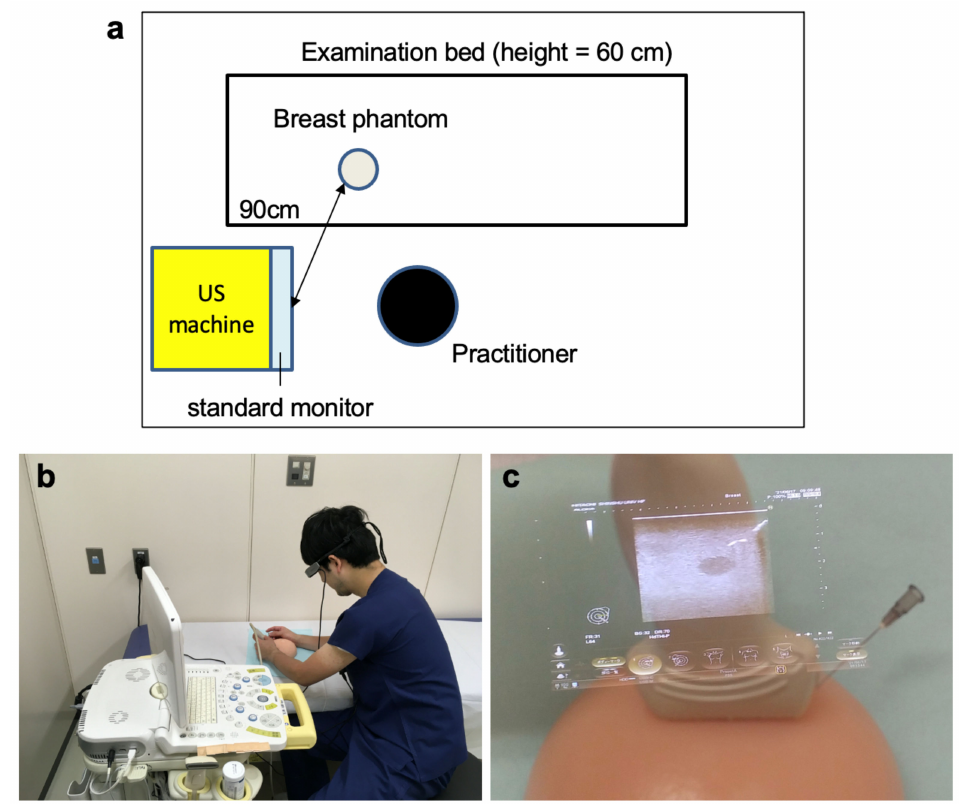
Figure 3. ( a ) Placement of the practitioner, US machine, and breast phantom during the procedure. The breast phantom was placed on the examination bed which was 60 cm in height. The US monitor was located at 90 cm distance from the breast phantom as indicated. The practitioner sat in front of the US monitor. ( b ) Photographs during US-guided procedure with the OST-HMD ( c ) A representative image projected on the OST-HMD when the procedure was performed. The view seen by the practitioner with OST-HMD. The practitioner can see the US image on the display of OST-HMD over the actual view of the procedural